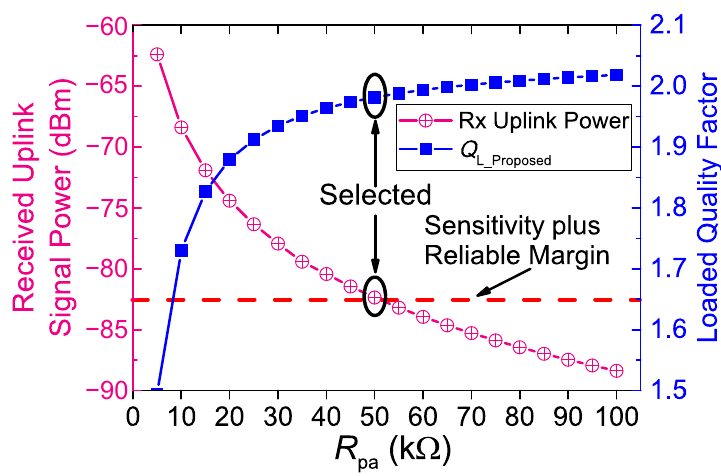
Figure 8. Simulated received uplink signal power and the loaded quality factor Q L_Proposed versus R isolate , when the coil separation d = 40 mm.